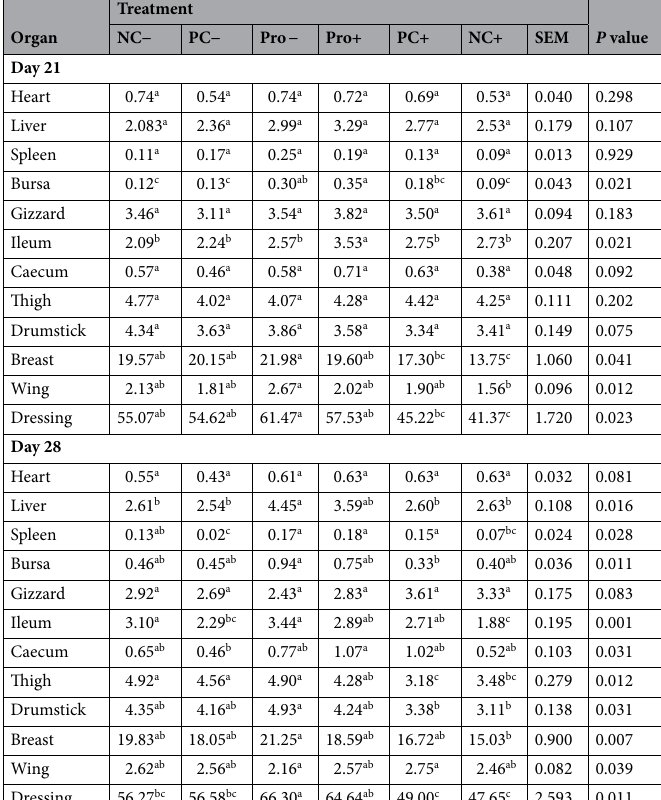
Table 3. Relative weights (% BW) of organs from broilers supplemented with probiotics and challenged with Pasteurella multocida . Values are means of two replicates and standard errors of means. Within each variable, values with the same superscript letter are not significantly different according to Duncan’s multiple range test (P > 0.05). NC−: unchallenged negative control; PC−: unchallenged positive control; Pro−: unchallenged probiotics control; Pro+: challenged probiotic control; PC+: challenged positive control; NC+: challenged negative